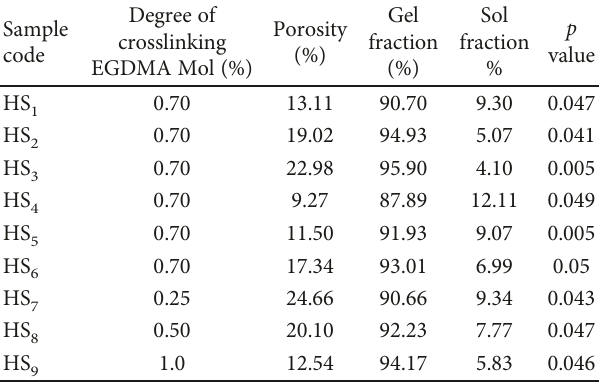
Table 5: E ff ect of di ff erent concentration of AA on the drug release kinetics of Poly (CMCS- g -AA) hydrogels in solutions of di ff erent pH using EGDMA as crosslinking agent (0.7% of